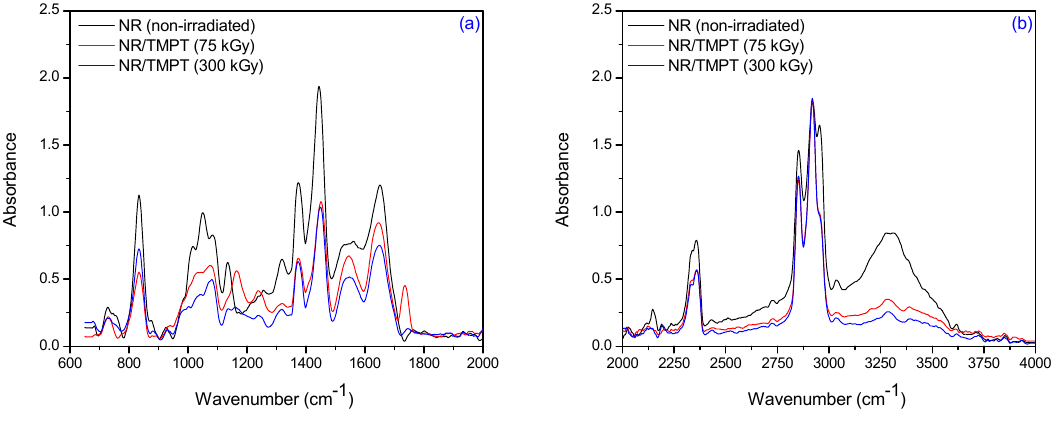
Figure 10. FTIR spectra in the range of ( a ) 2000 cm − 1 –600 cm − 1 and ( b ) 4000 cm − 1 –2000 cm − 1 for NR/TMPT irradiated at 75 kGy and 300 kGy.